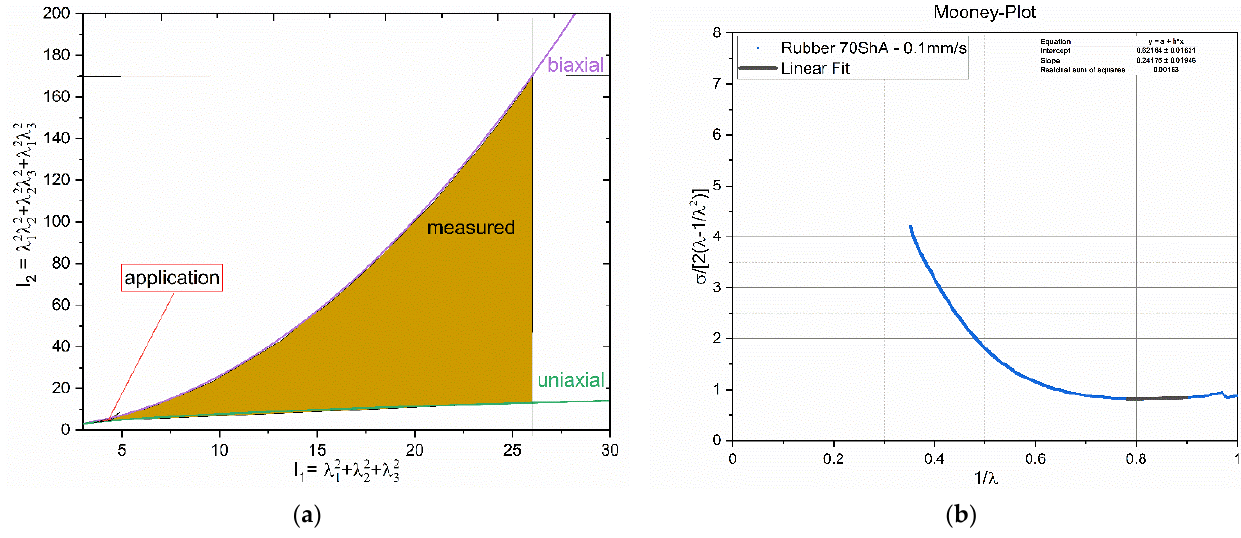
Figure 16. Results of the exemplary tests: ( a ) measured strain states ( b ) Mooney-plot and estimated material parameters for the Mooney–Rivlin constitutive model.